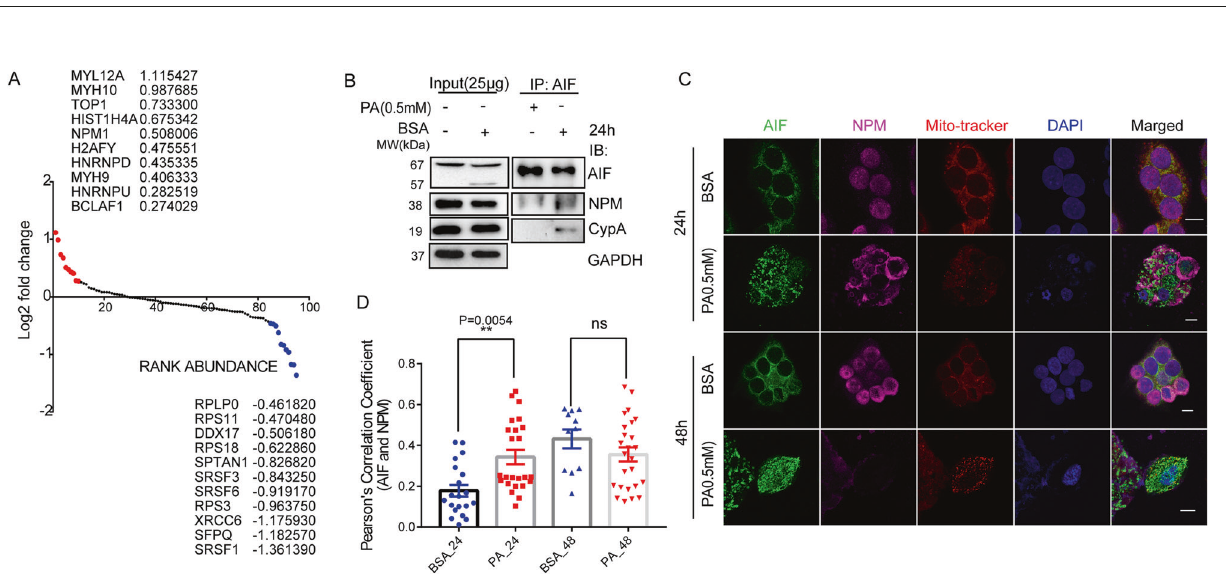
Fig. 8 Palmitic acid promotes AIF-mediated cell death in HepG2 cells. PA potentiates caspase-independent cell death over caspase- dependent. PA-induced HepG2 cells were harvested at 0 h, 12 h, 24 h, and 48 h time points. The caspase-dependent molecules like c-Cas3, c- Cas9, Bax, and Bid and caspase-independent molecules like CypA, c-PARP, and tAIF were probed in western blot analysis ( A ). GAPDH was used as a loading control. Proteins were quanti fi ed as a normalized fold change density compared to individual control conditions of particular time points ( B – E ). Two-way ANOVA followed by Sidak ’ s multiple comparisons test was applied for statistical analyses. USP7/p53 axis exacerbates Palmitic acid-induced AIF-mediated cell death. A group of HepG2 cells that were transiently expressed WT-USP7, siRNA USP7, catalytic inactive mutant (C223S) of USP7 and pretreated with pharmacological inhibitors, P22077 and P5091 (10 and 20 µM for 24 h) were treated with or without palmitic acid (0.5 mM) for 24 h and were subjected for immunoblot assay. Caspases dependent (cCas3 and cCas9) and